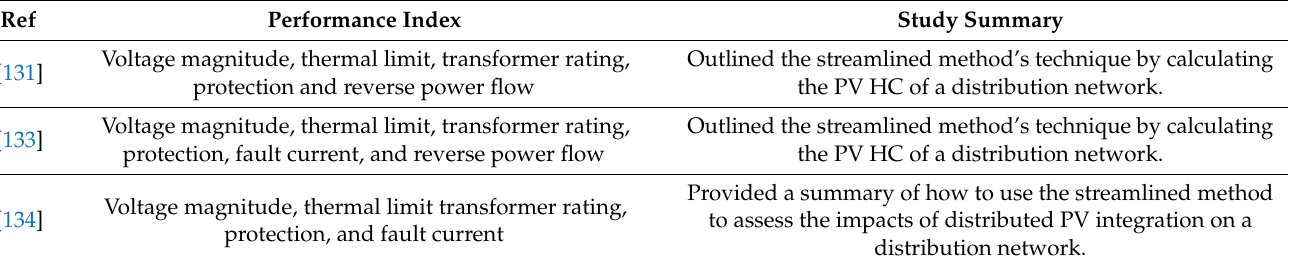
Figure 7. Streamlined method illustration. Table 6. Summary of studies that adopt the streamlined method for PV hosting capacity determination.